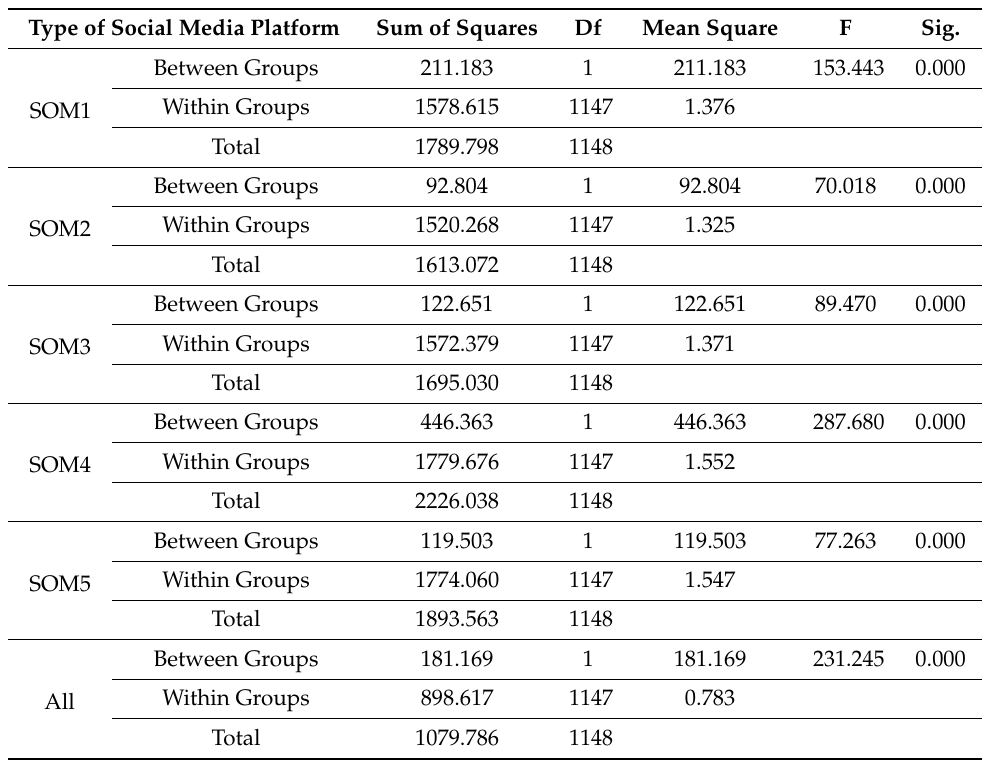
Table 8. ANOVA analysis result for hypothesis (H2a).